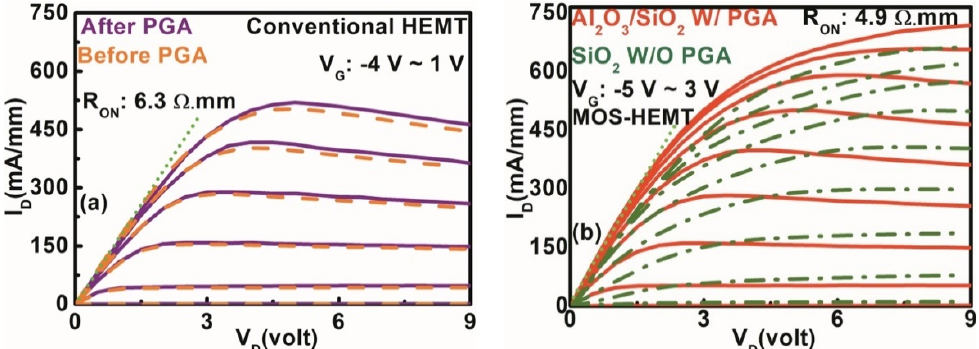
Figure 3. XPS of the AlGaN/GaN device ( a ) without and ( b ) with dual surface treatment.